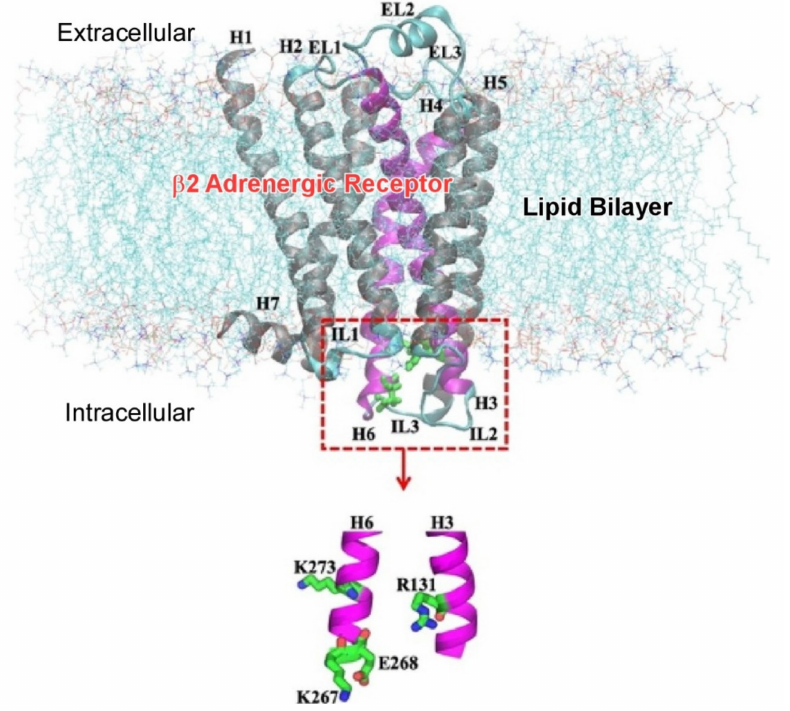
Figure 3. A β 2 adrenergic receptor in a lipid bilayer composed of palmoyloleoylphosphatidylcholine for molecular dynamics simulation. Reprinted with permission from Reference [122]. Copyright 2021, Chemical Society of